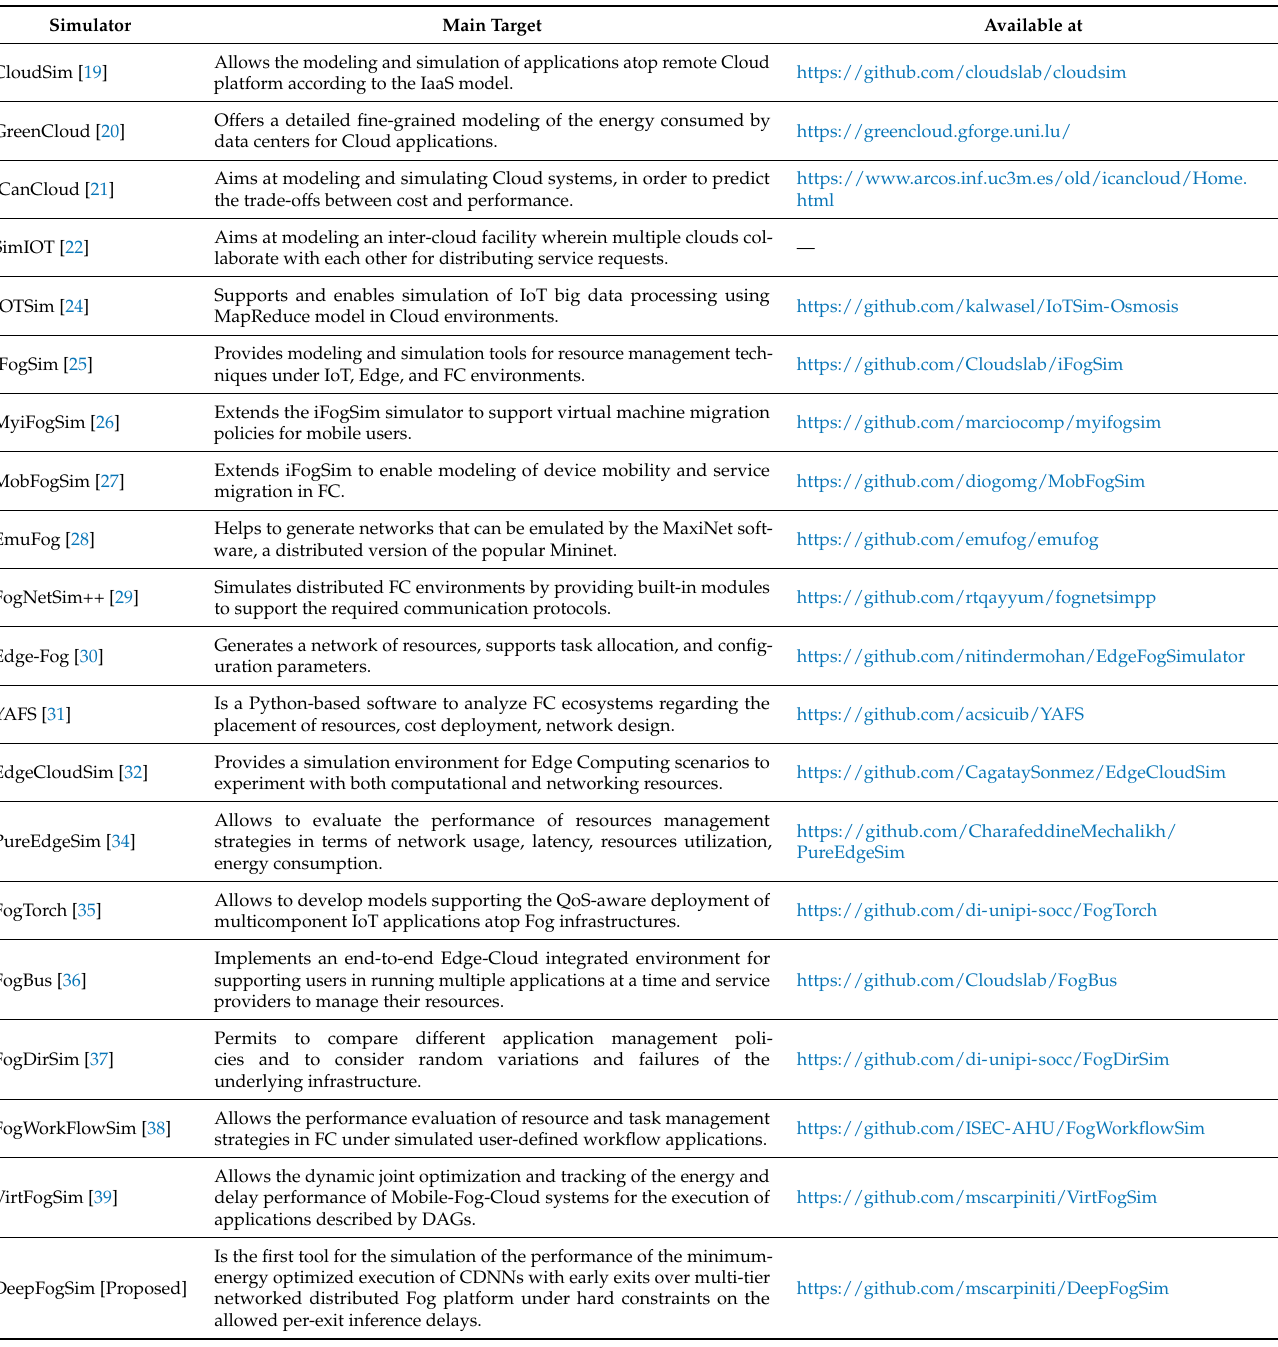
Table 1. Available toolkits for the simulation of Fog-based ecosystems. Simulator Main Target Available